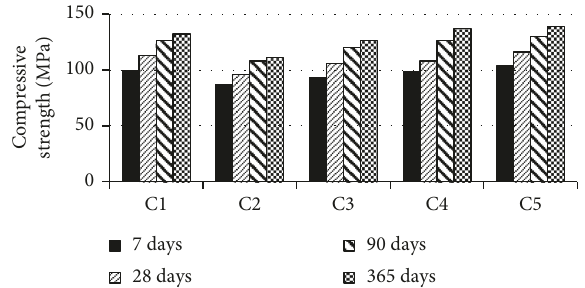
Figure 3: Compressive strength of